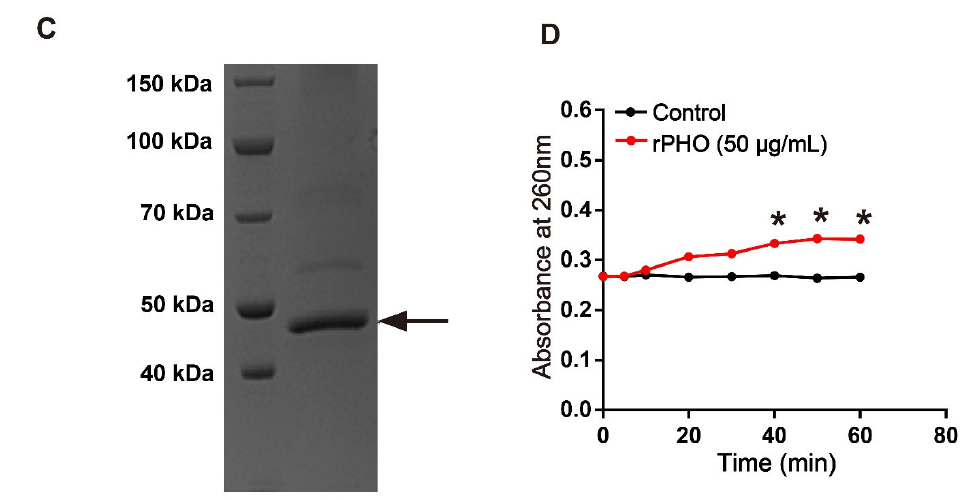
Figure 1. Recombinant photolyase-thymine protein (rPHO) from T. thermophilus displayed CPD photorepair activity. ( A ) Mechanism underlying photolyase-mediated repair of UVB-induced DNA damage. ( B ) Structure of recombinant photolyase-thymine (rPHO). ( C ) The purified protein was separated by SDS-PAGE; arrow shows the target protein (rPHO). ( D ) Enzymatic activity assay was used to examine the photorepair activity of rPHO. CPD photoproducts were formed by exposure of Oligo (dT)16 to UVB; then, the CPD photoproducts were incubated with rPHO (50 μ g/mL) for 0, 5, 10, and 20 min, followed by the detection of the OD at 260 nm. * p <